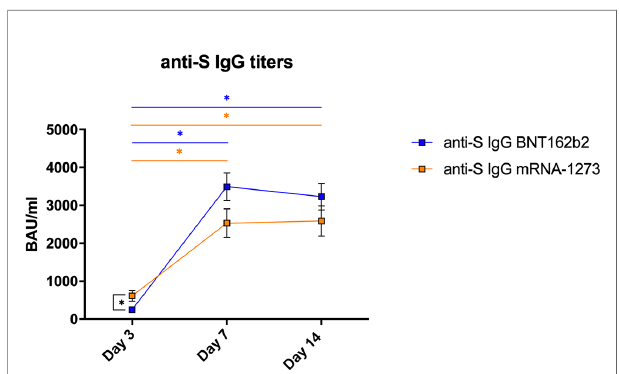
FIGURE 1 | Speci fi c humoral responses in vaccinated healthy subjects. Mean ±SEM values for S-protein speci fi c IgG antibodies (BAU/ml) measured in plasma from volunteers vaccinated with BNT162b2 (n=21) or mRNA-1273 (n=19) after 3, 7 and 14 days of receiving the second dose of the vaccine. The linear mixed-effects regression model was adjusted to evaluate each immunological covariate ’ s evolution over time in each group. *Signi fi cant difference when p <